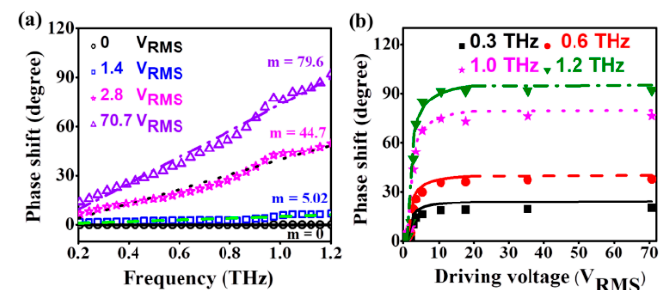
Figure 6. Phase shift properties as a function of ( a ) frequency for several values of applied voltage and ( b ) applied voltage at selected frequencies for an MDA-550 TN-LC-based THz phase shifter. The slope of the linear line fitting experimental data is denoted by m. The circles, squares, diamonds, and triangles are experimental data. The solid line, dash line, dot line, and dash–dot line are ( a ) linear fit and ( b ) theoretical curves.